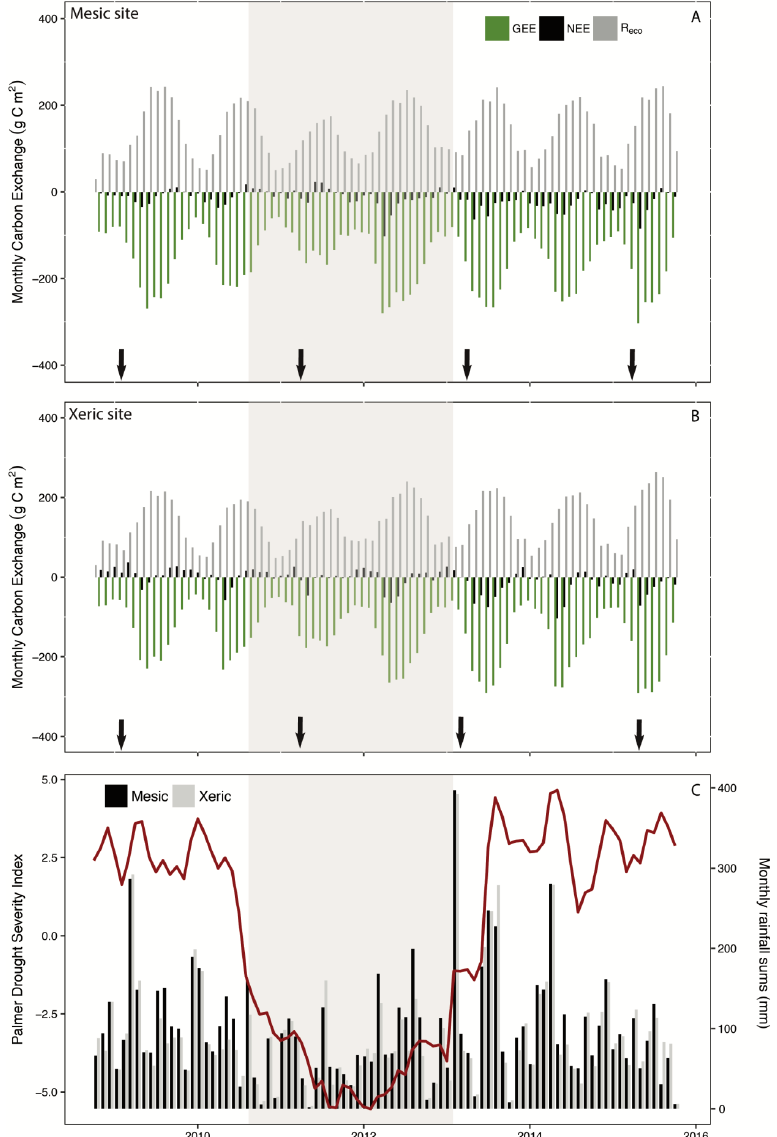
Figure 2. Monthly sums of Gross Ecosystem Exchange, Net Ecosystem Exchange and Ecosystem respiration for the mesic ( A ) and xeric sites ( B ), respectively; Palmer Drought Severity Index and summed monthly precipitation for the two stands ( C ). Shaded area indicates period of drought (PDSI < ´ 3.0), and arrows indicate dates of prescribed fire